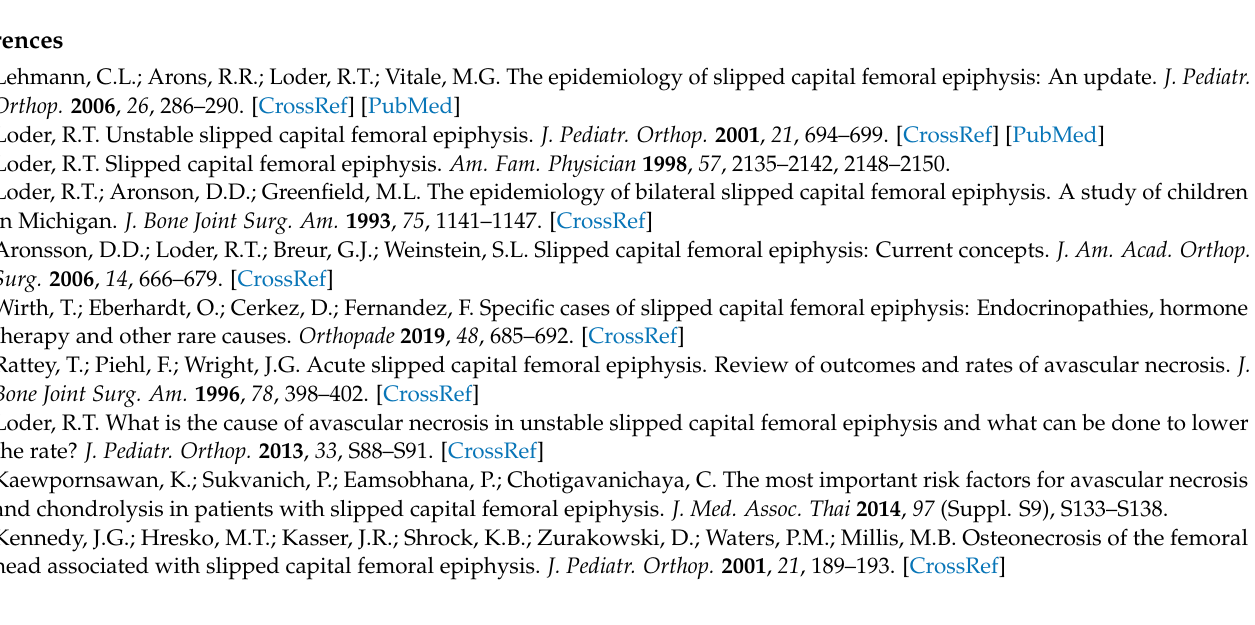
Figure S2: The prevalence of various surgical procedures (A–G) in slipped capital femoral